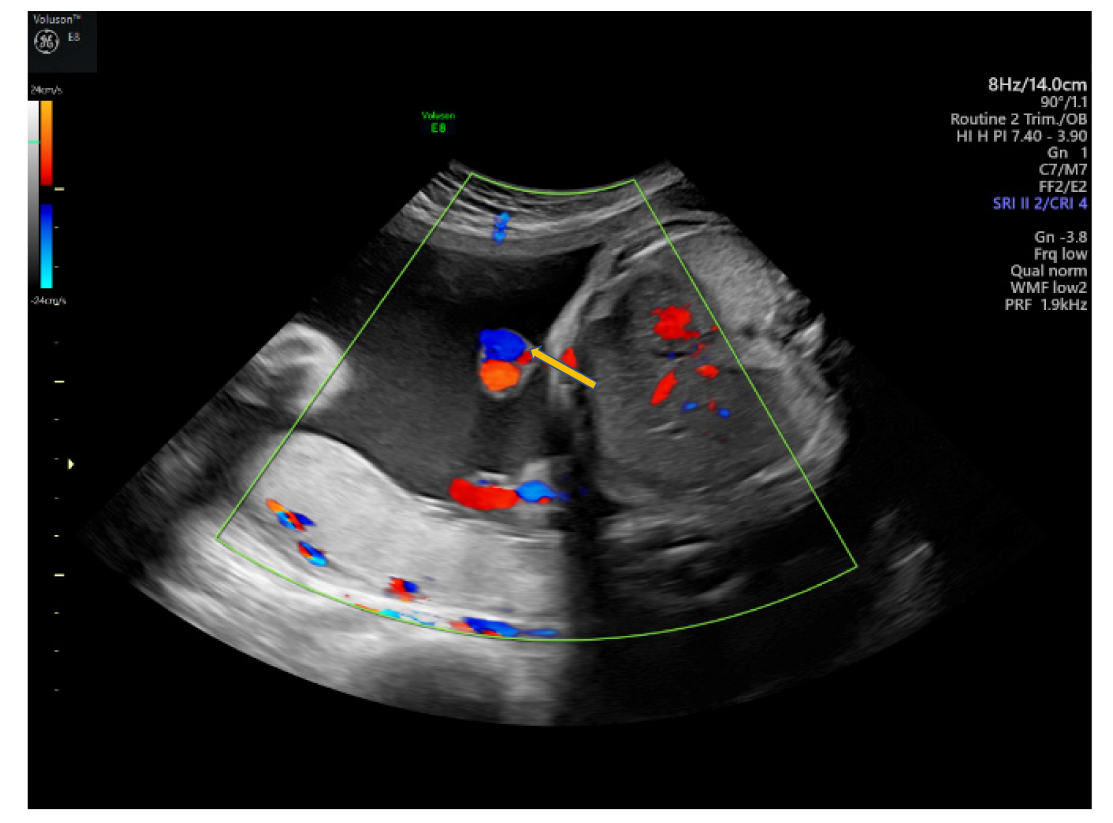
Figure 6. Hypoplasia of the umbilical artery (arrow).